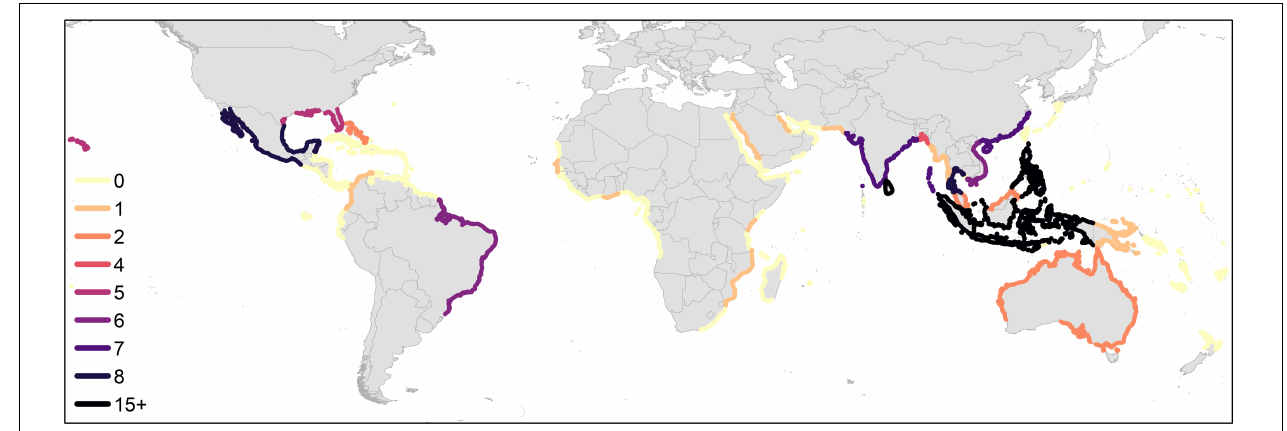
FIGURE 3 | Global map showing the location of countries that have mangroves and the number of restoration case studies recorded from each